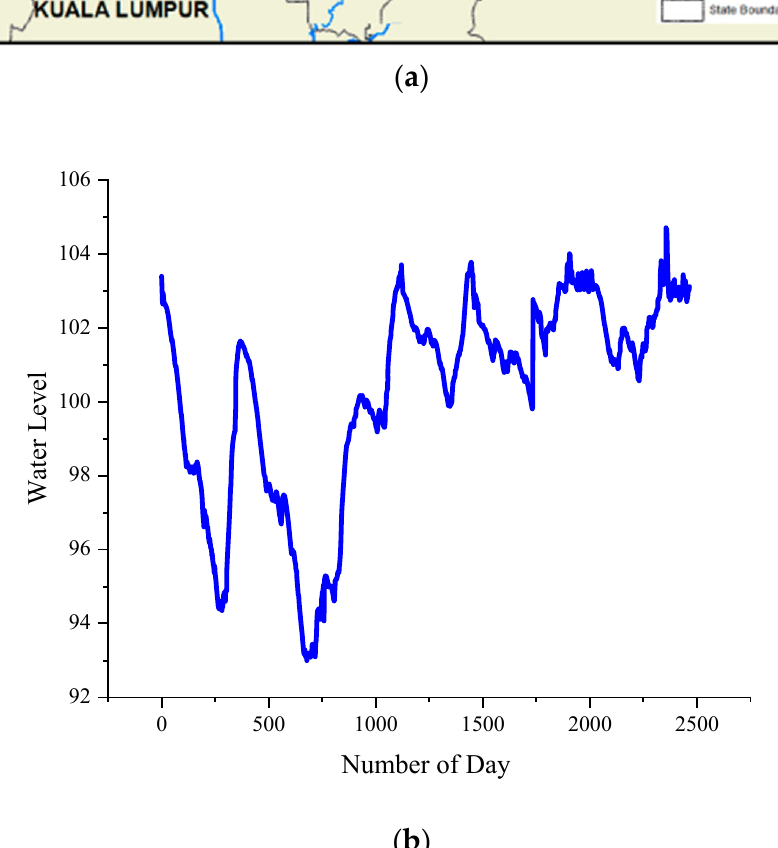
Figure 1. ( a ) Location of the case study [31], ( b ) Time series data.